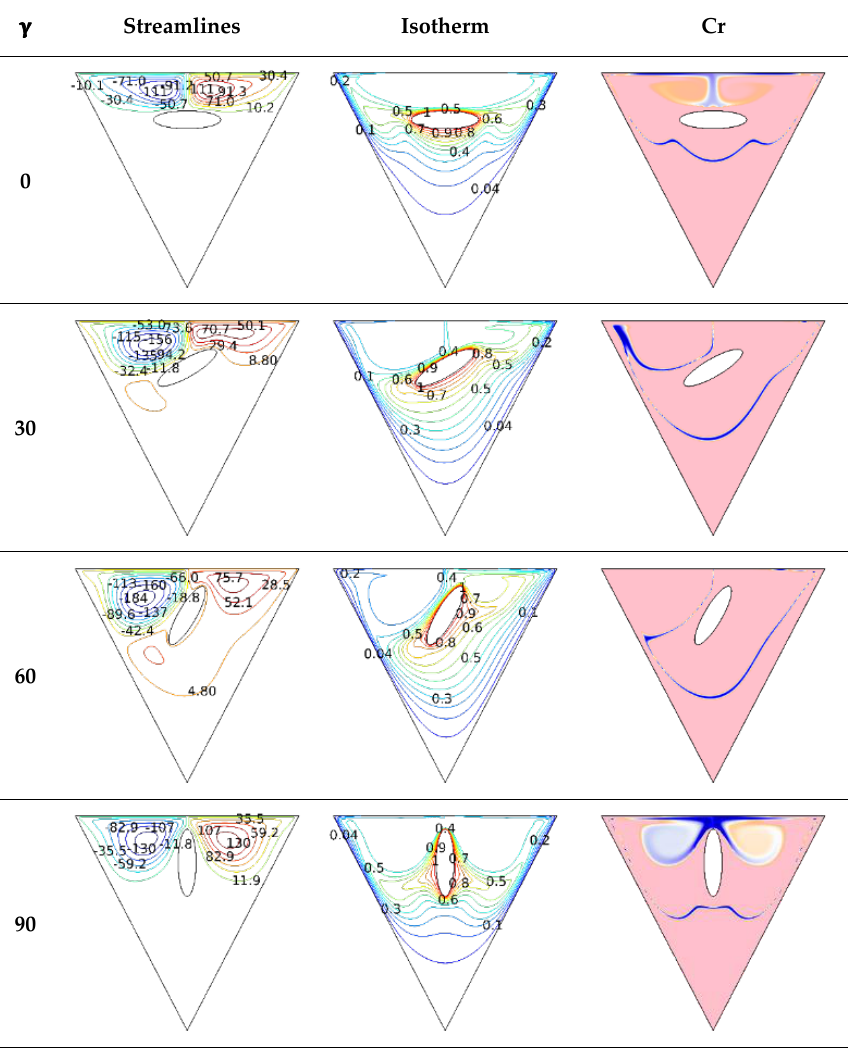
Figure 4. Features of the streamlines ( left ), isotherms ( middle ) and capacity ratio of NECPCM ( right ) for various values of 𝛾 . (The negative and positive sign numbers in the streamlines represent the direction and strength of flow, while the numbers in the isotherms mean the heating level.)